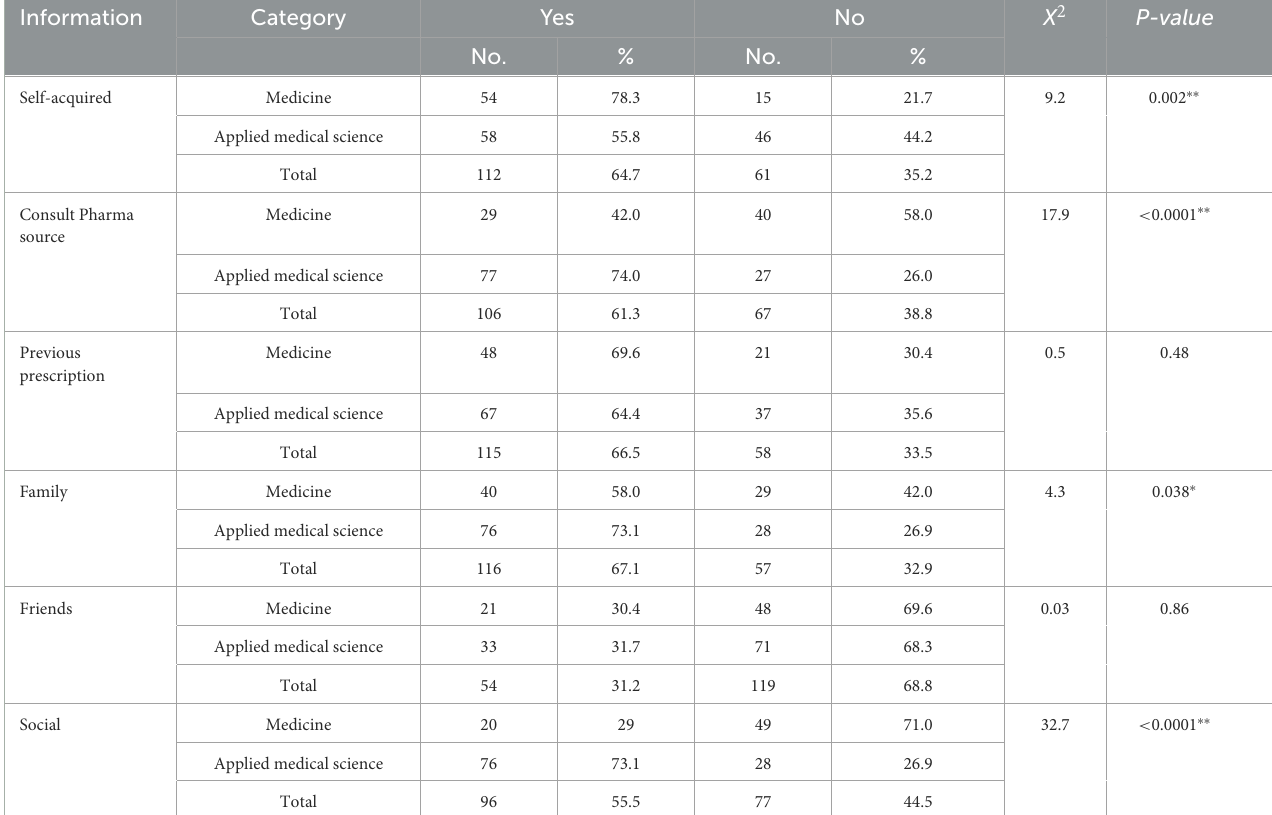
TABLE 5 Source of knowledge for self-medication ( N = 173).